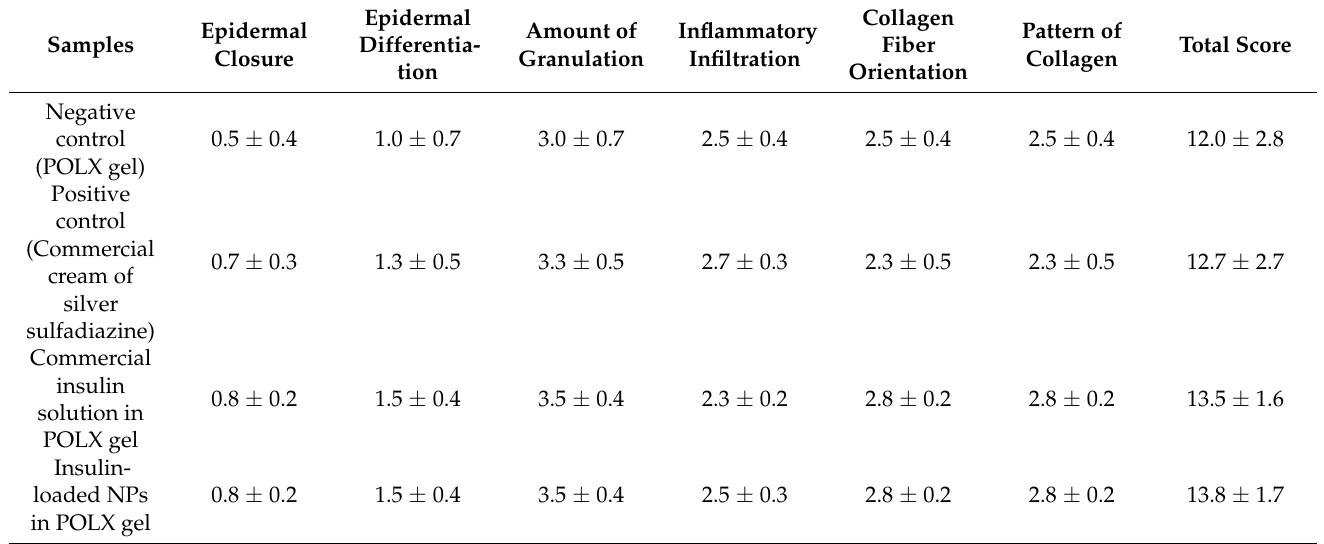
Table 4. Scoring of skin regeneration after 5-days of treatment (mean ± SEM), i.e., same end-point for all groups. Epidermal closure (ulcer 0 or closed 1); Epidermal differentiation (absent 0, spinous epidermal 1 or granular layer 2); Amount of granulation tissue (profound-1, moderate-2, scanty-3 or absent-4); Inflammatory infiltrate (plenty-1, moderate-2 or few-3); Collagen fiber orientation (vertical-1, mixed-2 or horizontal-3) and Pattern of collagen (reticular-1, mixed-2 or fascicle-3). Collagen Epidermal Pattern of Amount of Inflammatory Epidermal Total Fiber Differentia- Samples Collagen Granulation Infiltration Closure Orientation tion